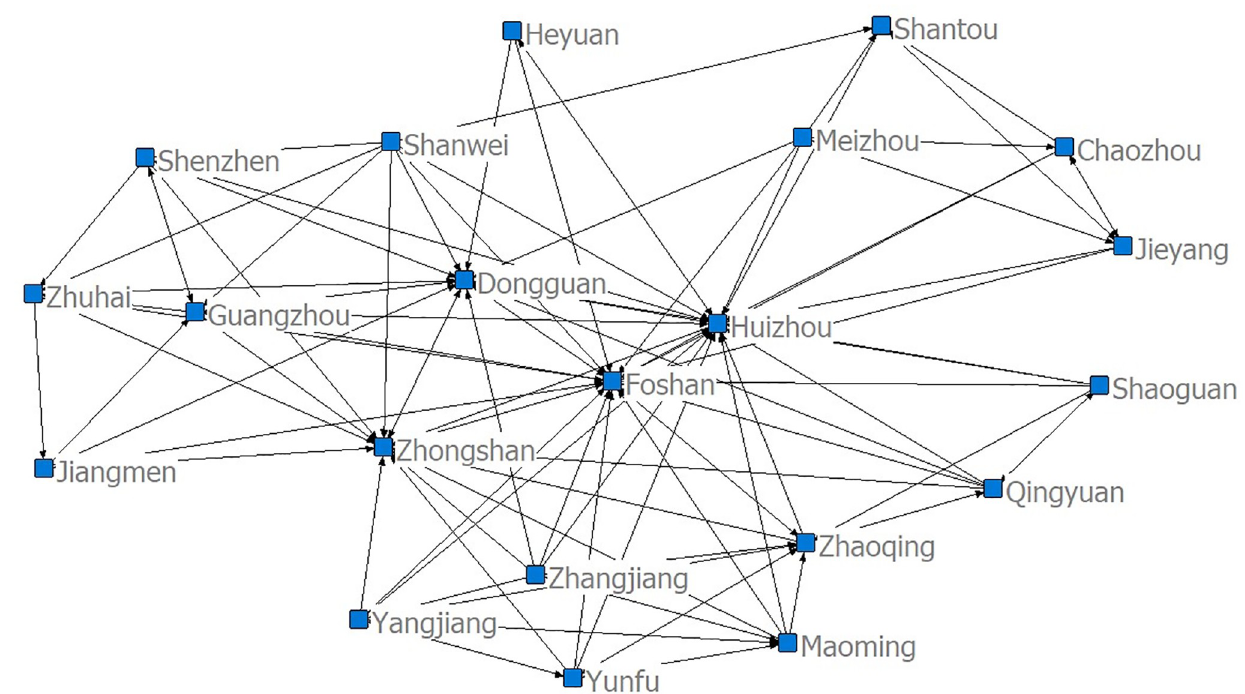
Fig 1. Spatial correlation network of urban innovation in Guangdong. https://doi.org/10.1371/journal.pone.0272026.g001 Table 5. Statistical results of the correlation between urban innovation. City Beneficial relationship Overflow relationship Total number of associations 5 9